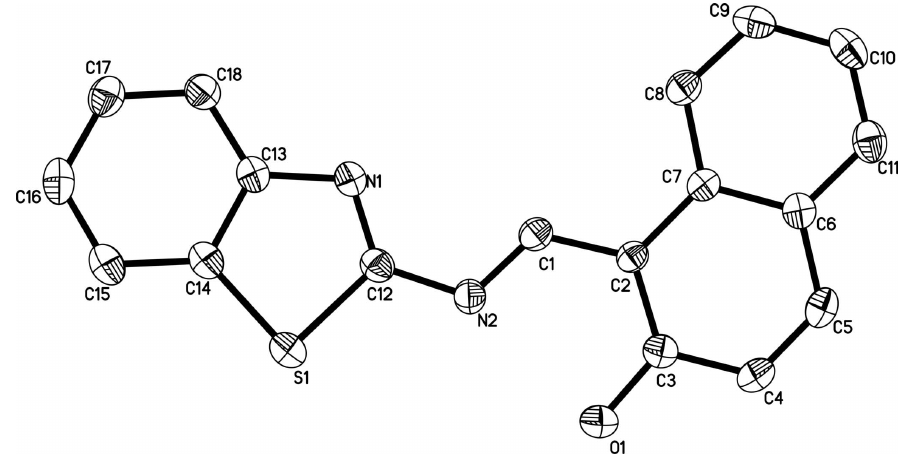
Figure 1 The structure of the title compound, showing 30% probability displacement ellipsoids and the atom-numbering scheme.